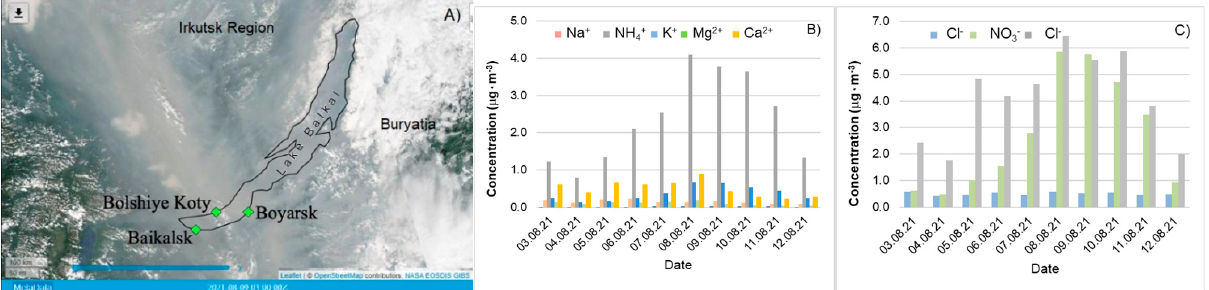
Figure 7. Satellite images of Lake Baikal with smoke plume from wildfires ( A ) 9 August 2021 [24]. Variability of the cation ( B ) and anion ( C ) concentrations in atmospheric aerosol in the air at the Bolshiye Koty research station in 2021, μ g/m 3 .